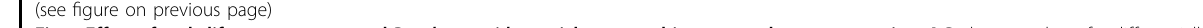
Fig. 5 Effect of early life sugar or targeted Parabacteroides enrichment on hippocampal gene expression. A Pathway analyses for differentially expressed genes (DEGs) at a P value < 0.01 in hippocampal tissue punches from rats fed early life sugar compared with controls. Upregulation by sugar is shown in red and downregulation by sugar in blue. B A heatmap depicting DEGs that survived the Benjamini – Hochberg corrected FDR of P < 0.05 in rats fed early life sugar compared with controls. Warmer colors (red) signify an increase in gene expression and cool colors (blue) a reduction in gene expression by treatment (CTL control, SUG early life sugar; n = 7/group). C A heatmap depicting DEGs that survived the Benjamini – Hochberg corrected FDR of P < 0.05 in rats with early life Parabacteroides enrichment compared with combined control groups. Warmer colors (red) signify an increase in gene expression and cool colors (blue) a reduction in gene expression by treatment ( n = 7, 14). D Pathway analyses for differentially expressed genes (DEGs) at a P value < 0.01 in rats enriched with Parabacteroides compared with combined controls. Upregulation by Parabacteroides transfer is shown in red and downregulation in blue. The dotted line indicates ±0.25 log2 fold